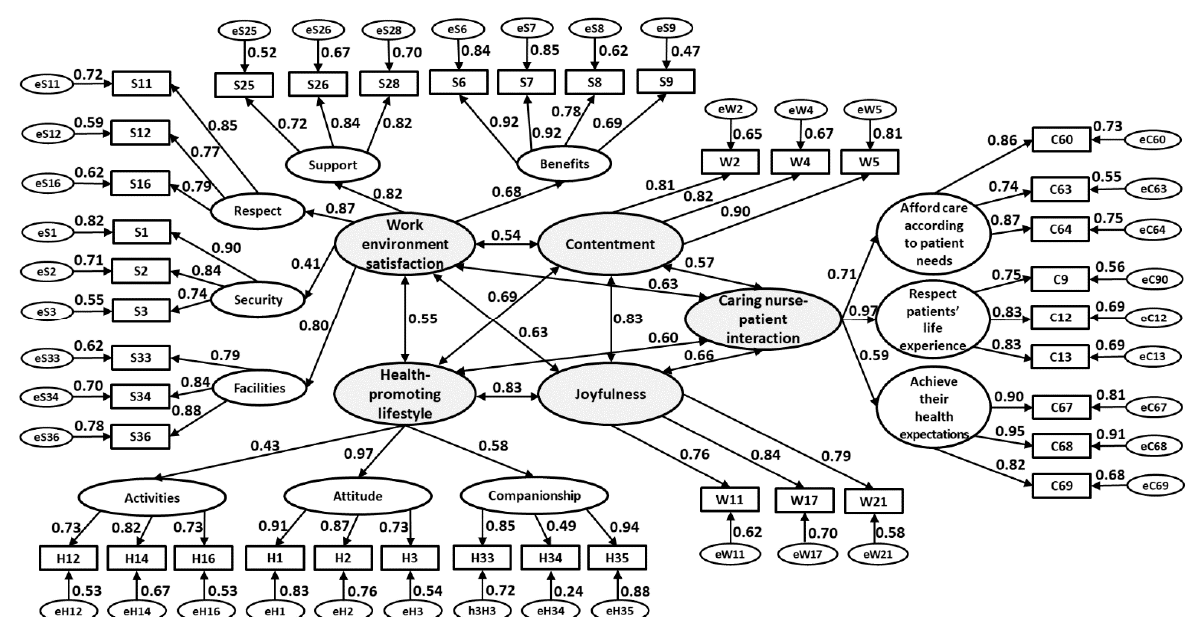
Figure 2. The final structural model of well-being versus CNPI competence .